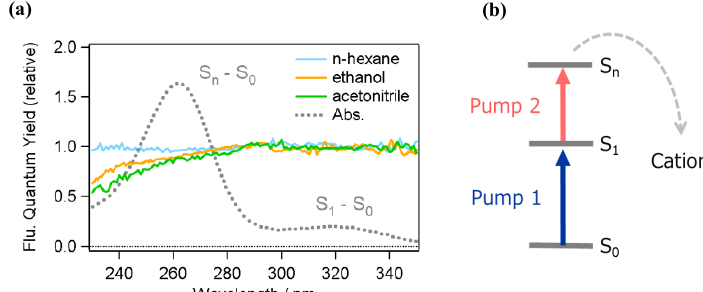
Fig. 1. (a) Steady-state absorption spectrum of TMPD in acetonitrile (grey dashed). Relative fluorescence quantum yield of TMPD in acetonitrile (orange line) and in n -hexane (blue line) normalized at 340 nm were also shown. (b) Schematic diagram of photoionization via higher excited states induced by femtosecond double-pulse